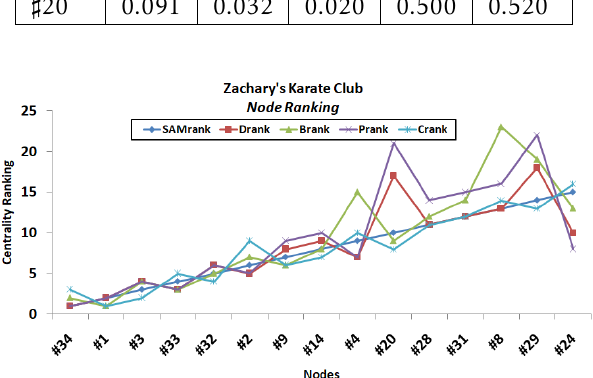
Figure 4. Ranking of top 15 nodes from Zachary‘s Karate Club, sorted by SAM centrality